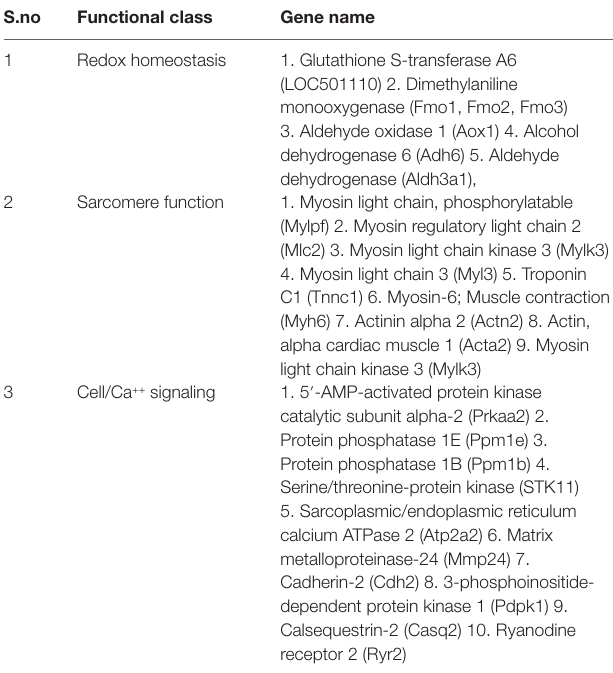
TABlE 3 | Functional class of cardiac disease related genes modulated after ISO treatment.